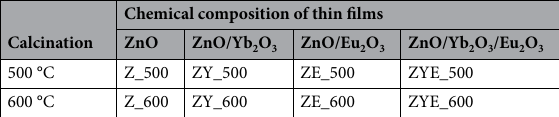
Table 1. Sample designations of all prepared thin films